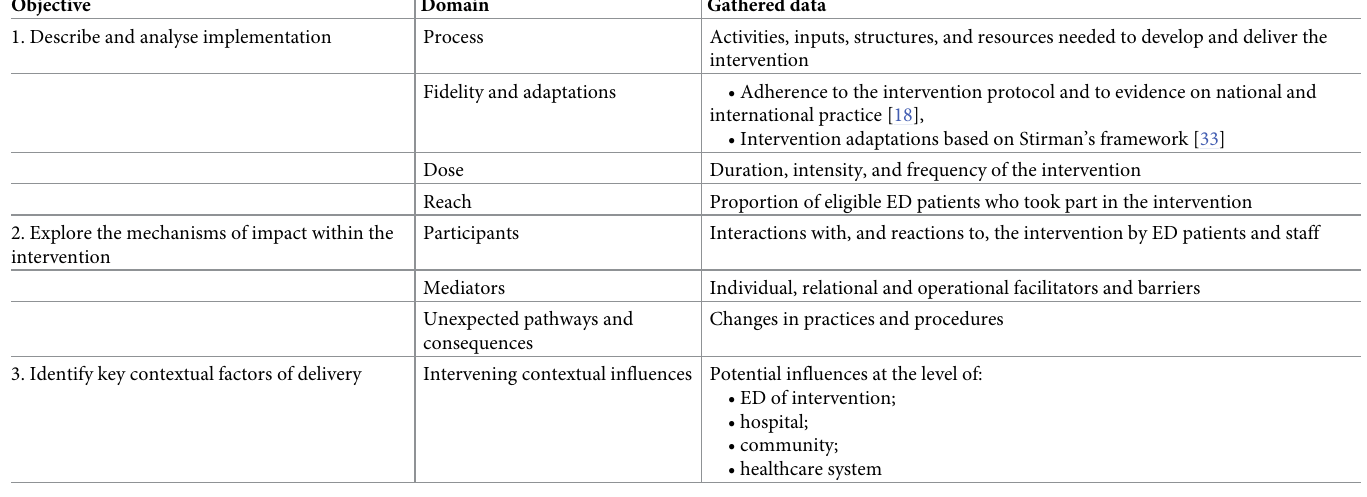
Table 1. Process evaluation